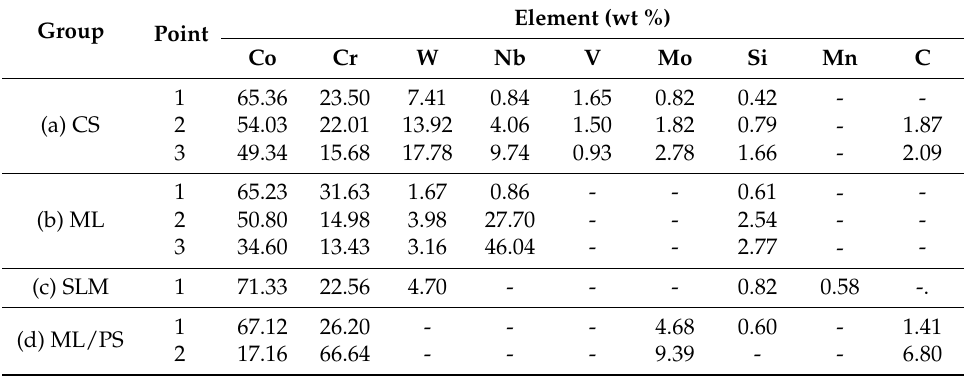
Table 2. Results of quantitative elemental point analysis (see Figure 5).